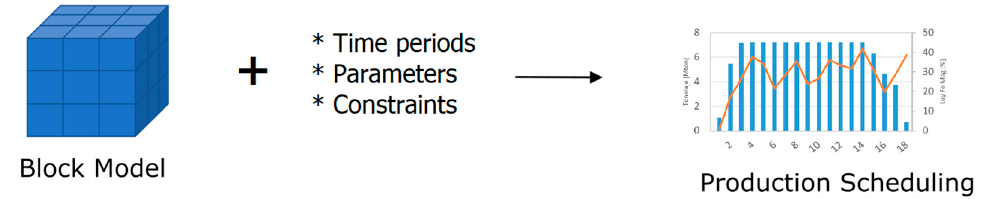
Figure 3. Deterministic Direct Block Scheduling approach, where production scheduling comes out right from solving an optimization model.